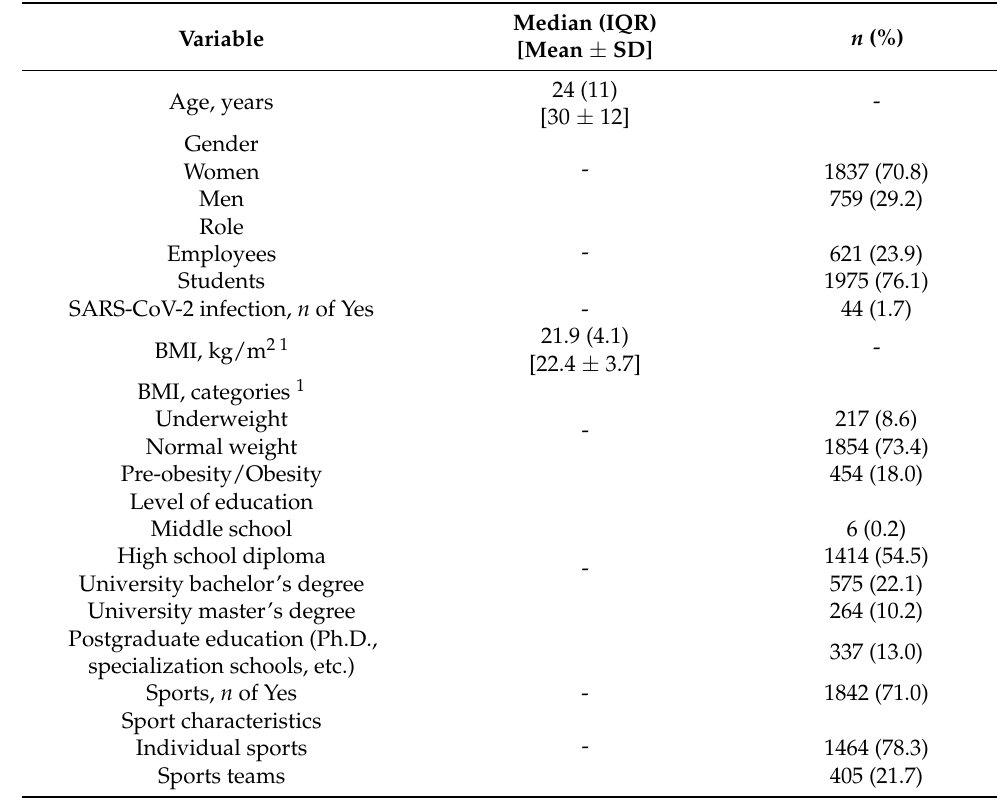
Table 1. Characteristics of the sample ( N = 2596).